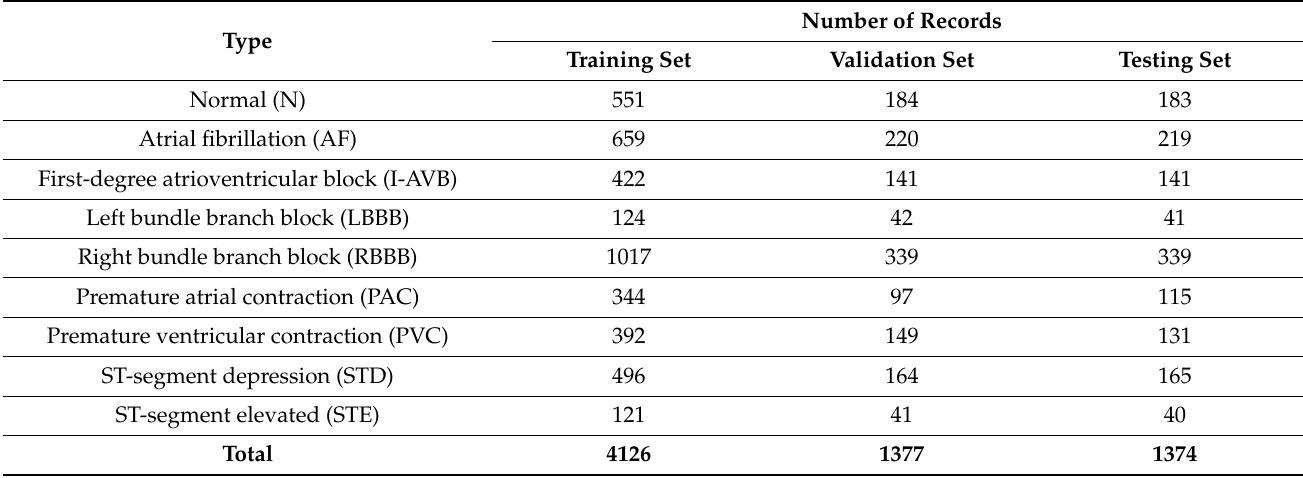
Table 1. Heartbeat types and the number of